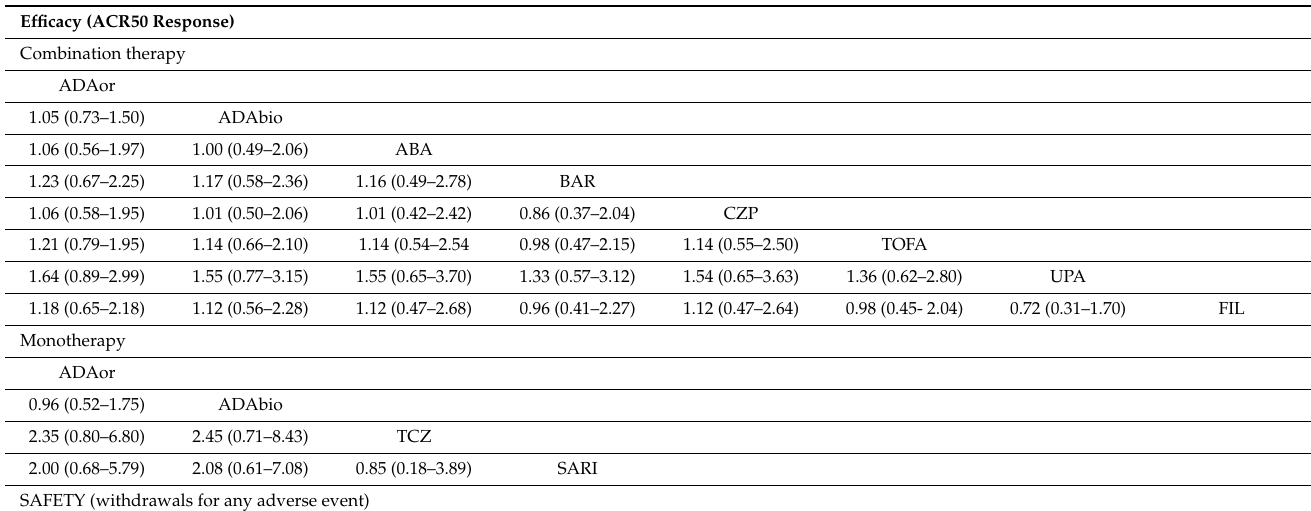
Table 3. Mean posterior probability of Efficacy (top panel) and Safety (bottom panel) in combination therapy with methotrexate or as monotherapy at 24 weeks of treatment for each